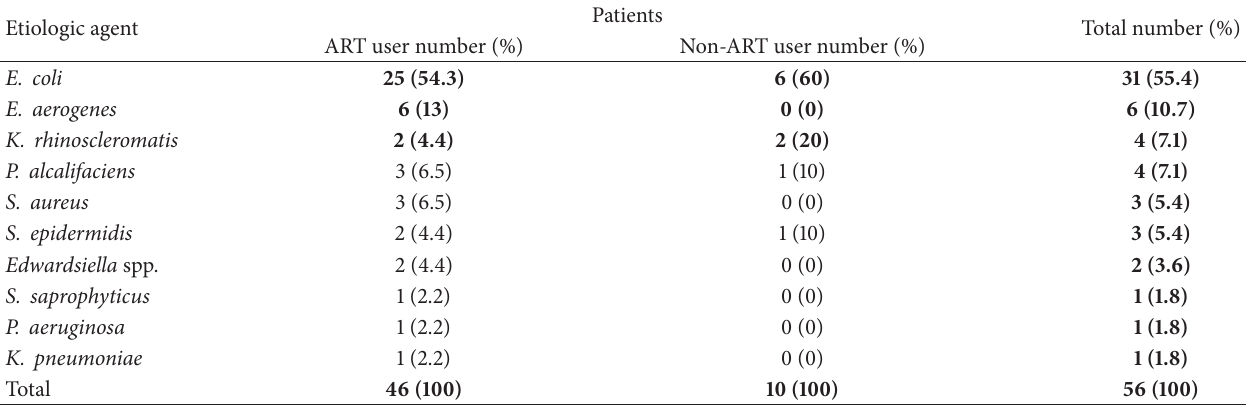
Table 4: Distribution of etiologic agents of UTI among ART and non-ART user patients, Jimma University Specialized Hospital, Ethiopia, 2012.